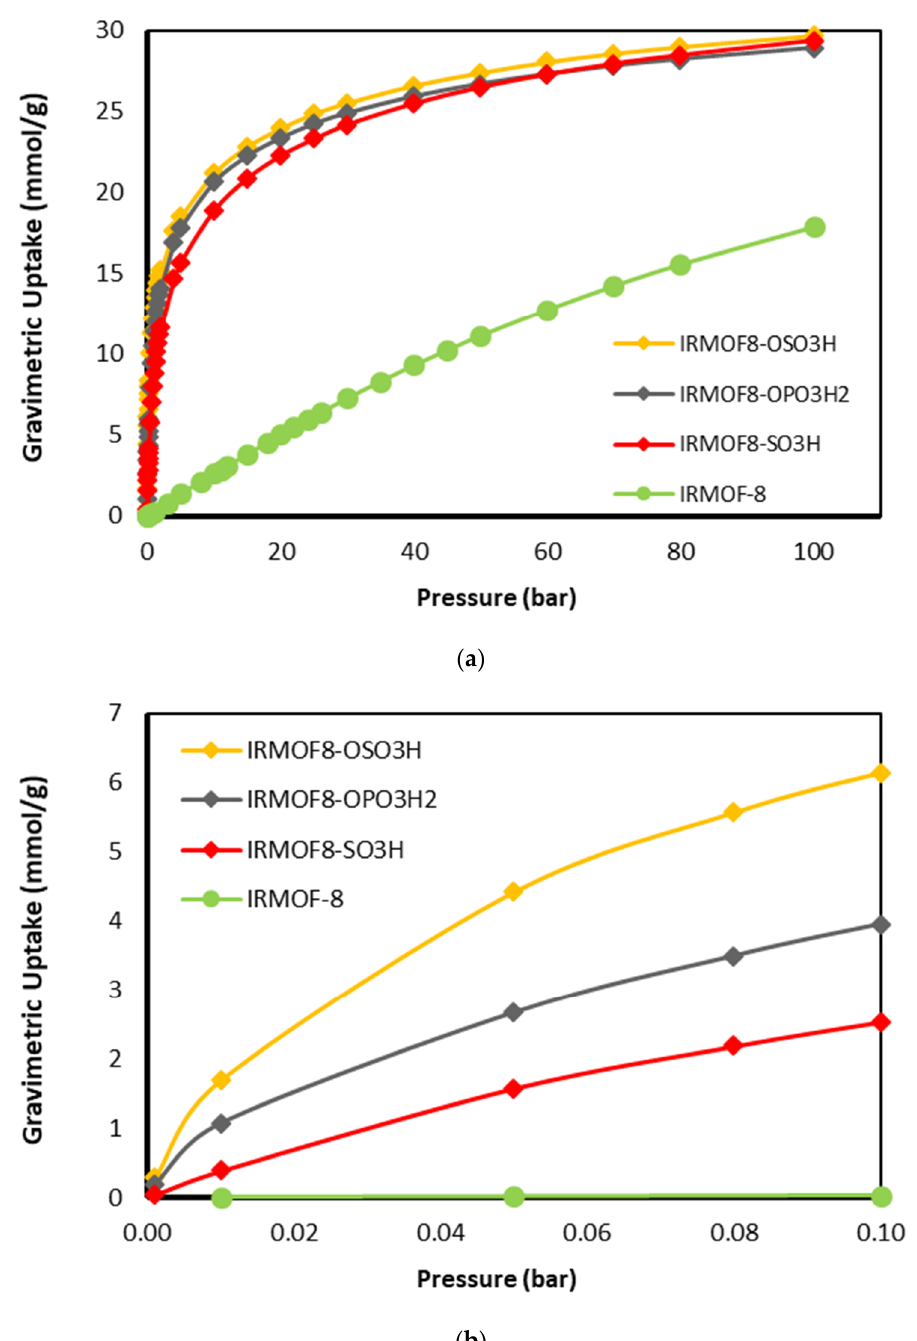
Figure 6. Absolute gravimetric isotherms for IRMOF8 and IRMOF8-n (n: -OSO 3 H, -OPO 3 H 2 , -SO 3 H) at T = 298 K and pressure ranges up to ( a ) 100 bar and ( b ) 0.10 bar .